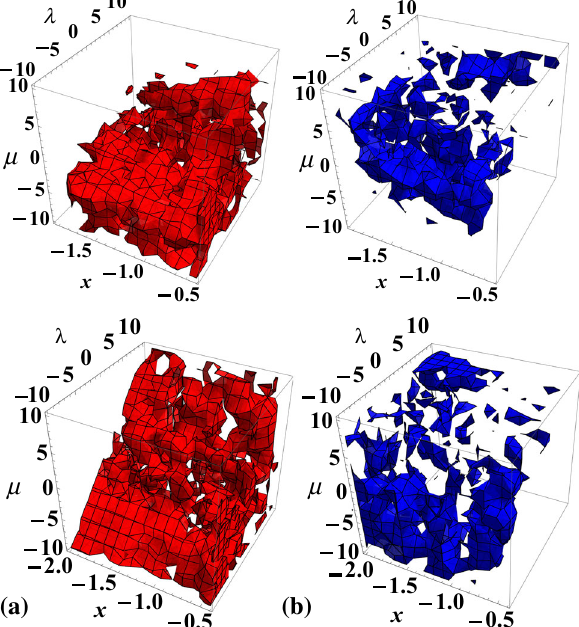
Fig. 1 Stability of A + for a ω = 1, and for b ω = 0. For parameters in the red region (left graph of each panel) A + is a source and for parameters in the blue region (right graph of each panel) it is a